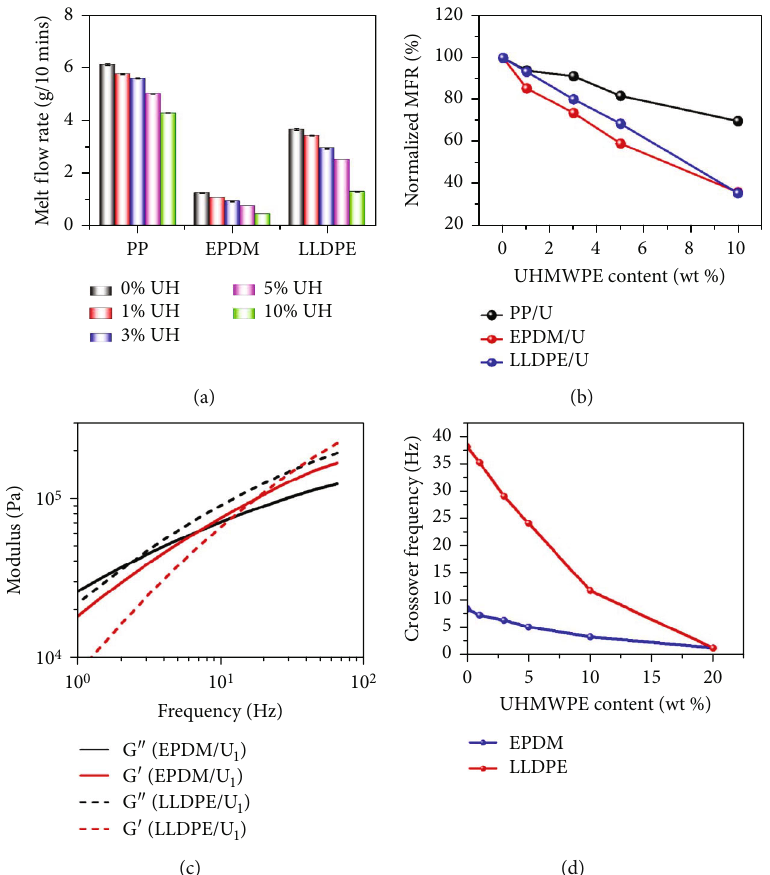
Figure 4: (a) Melt fl ow rate of three blends. (b) Normalized MFR (melt fl ow rate) of three blends. (c) Modulus versus frequency at 190 ° C for EPDM/U1 and LLDPE/U1. (d) Crossover frequency versus UHMWPE content at 190 ° C for EPDM/U and